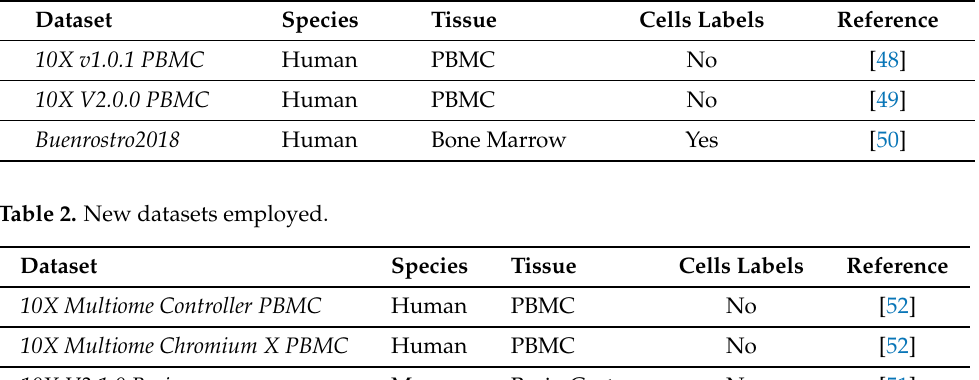
Table 1. Old datasets employed. Dataset